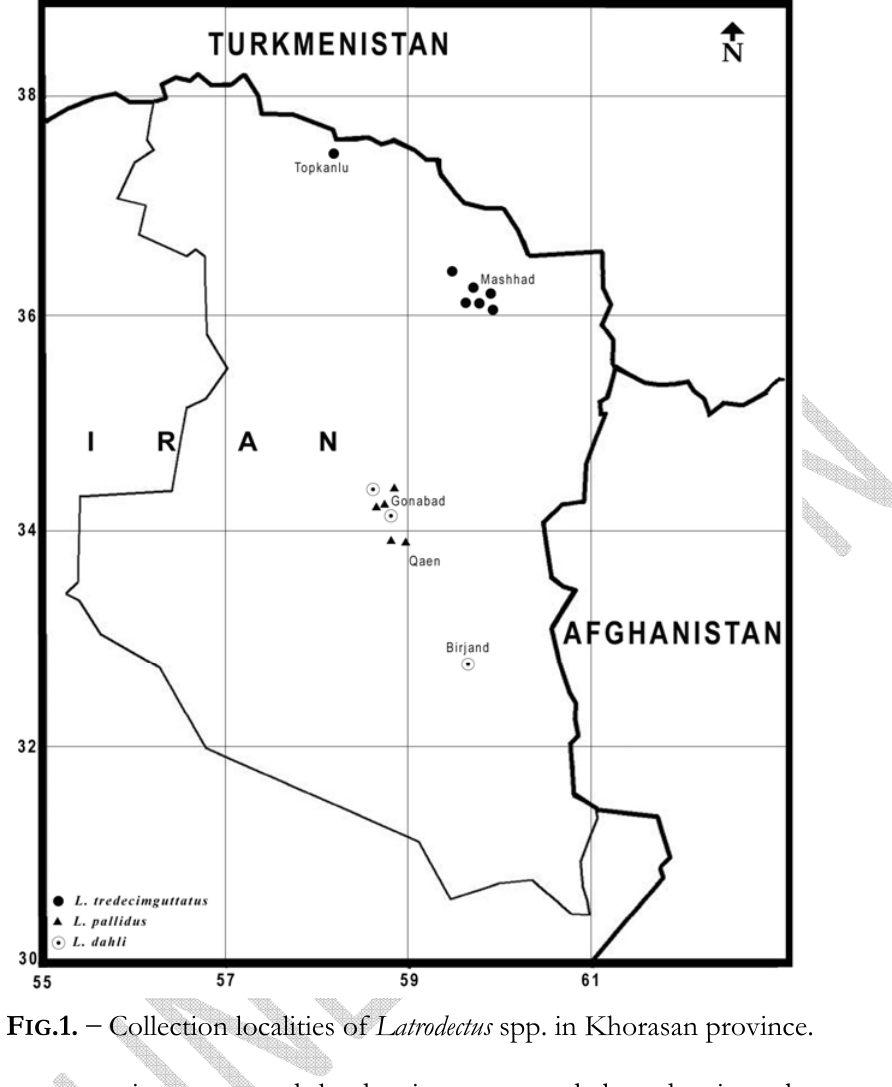
_ F IG .1. Collection localities of Latrodectus spp. in Khorasan